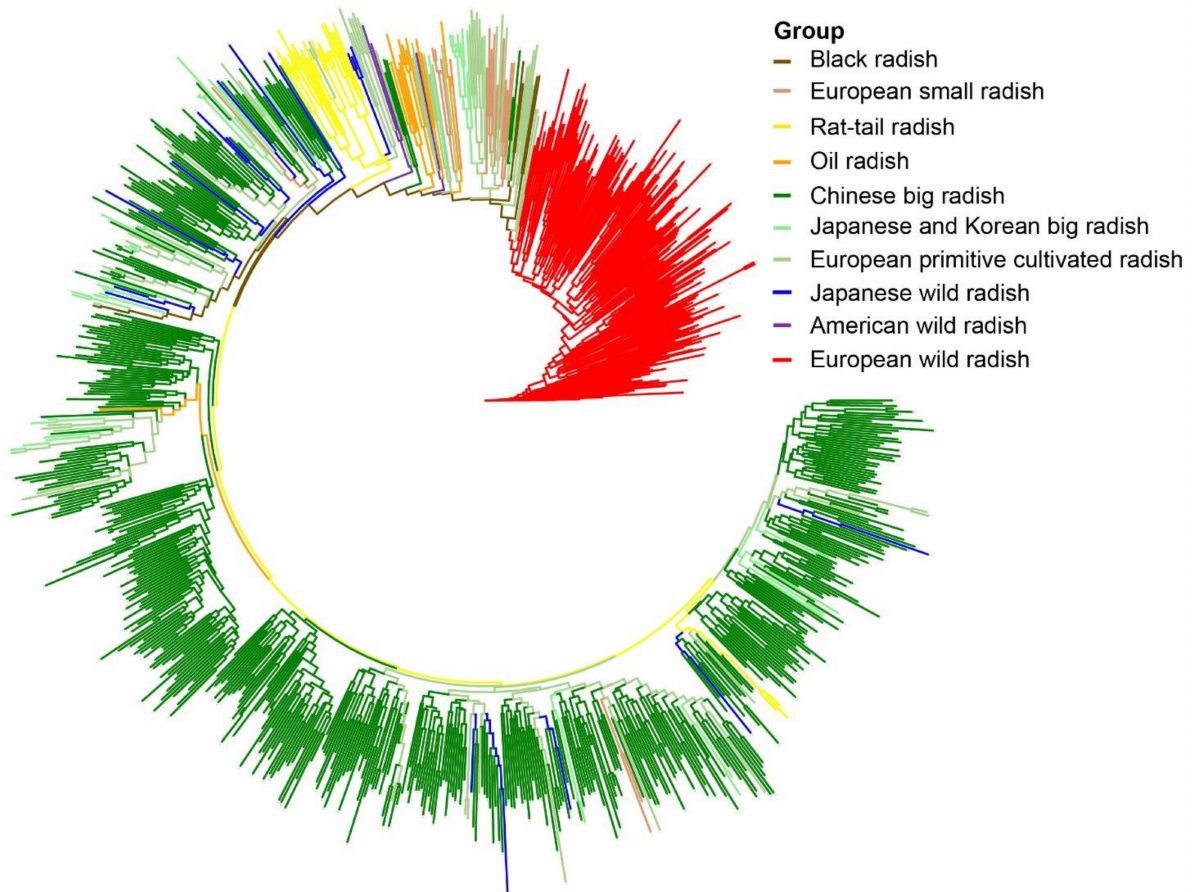
Figure 2. Phylogram of 939 radish genotypes based on SSR-Seq with 38 pairs of SSR